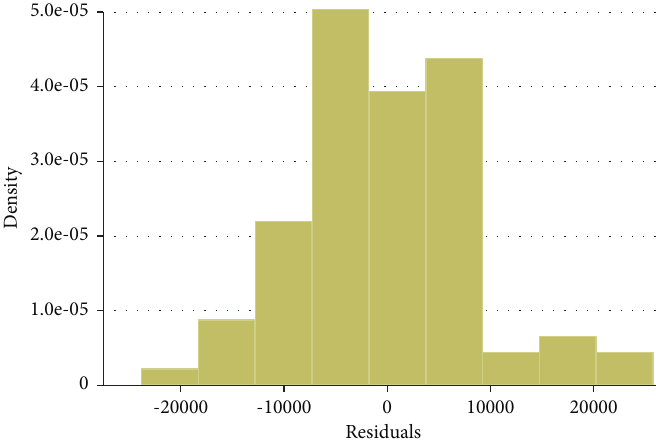
Figure 4: Histogram of the